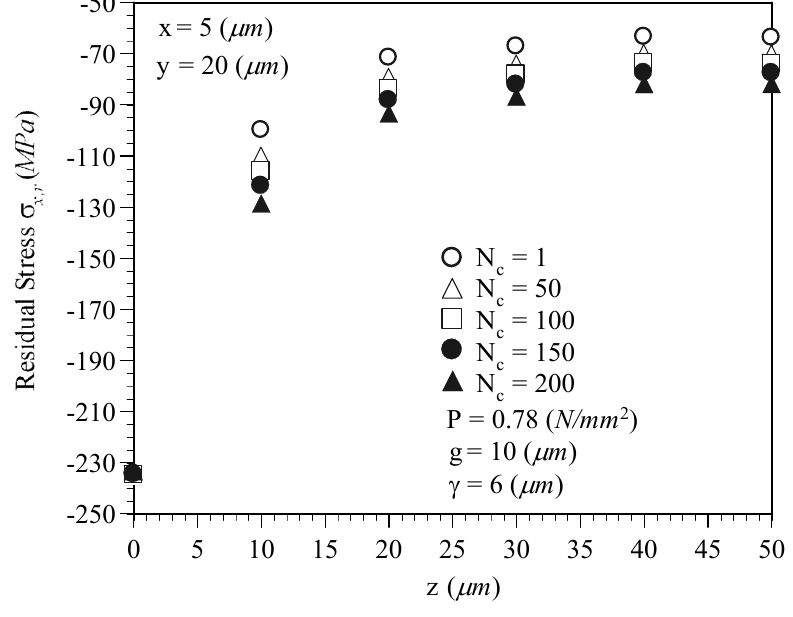
Figure 12. Distribution of residual stress of the microcantilever beam along the z-axis for various switching